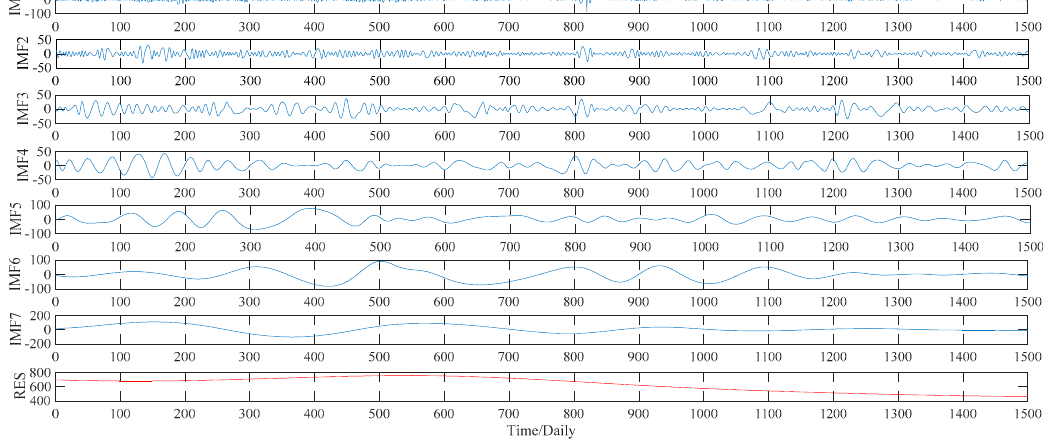
Figure 7. Decomposition results of the empirical mode decomposition (EMD) method (wheat). Algorithms 2017 , 10 , 108